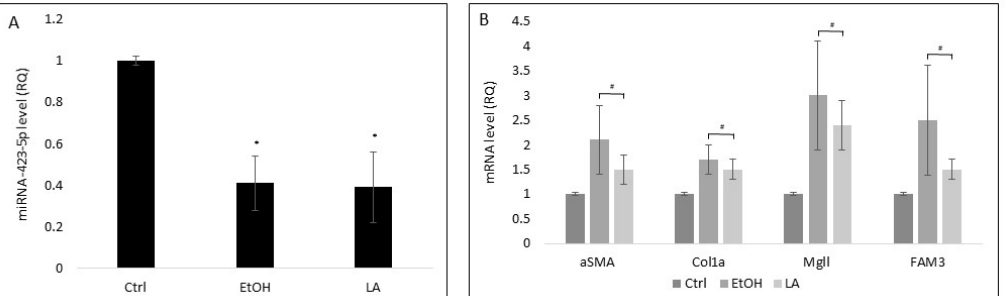
Figure 8. The effect of stress model on miR-423-5p levels and differentiation markers in pHSCs. HepG2 cells were exposed to either 80 mM EtOH or 500 µM lauric acid for 5 days, after which, HepG2 EVs were purified. HepG2 EVs miRNA was purified and quantified and miR-423-5p levels were determined. ( A ) The effect of stress on miR-423-5p levels in HepG2 EVs. ( B ) pHSCs were in- cubated (24 h) with HepG2 EVs purified following HepG2 exposure to stress conditions. pHSCs were then harvested and αSMA, Col1a, Mgll , and FAM3 mRNA levels were quantified. Results are expressed as mean ± SEM of 3 independent experiments. * Significantly lower than Ctrl; # Signifi- cantly higher than Ctrl, p < 0.05 (ANOVA with a post-hoc Bonferroni-adjusted Student’s t -test).